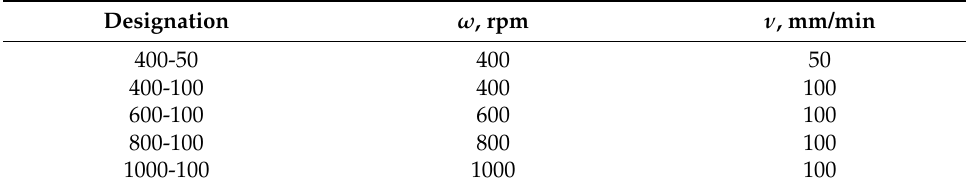
Table 1. Welding parameters and designations of the studied